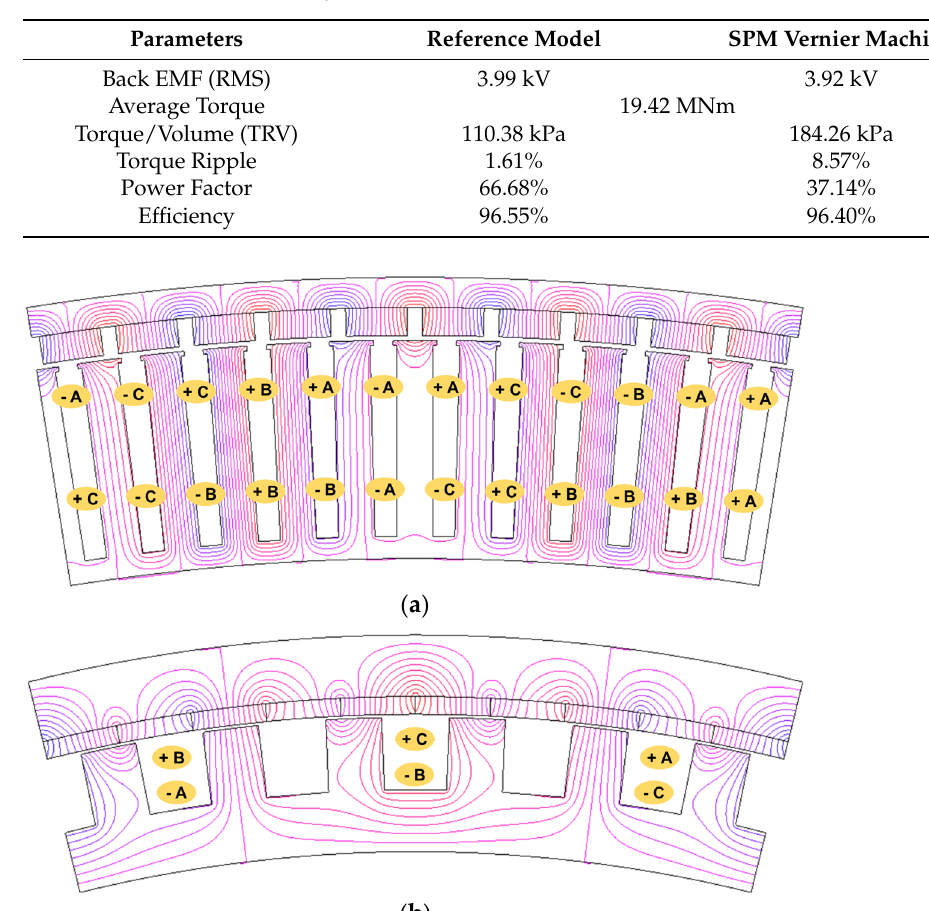
Figure 10. No-load flux lines ( a ) reference model, ( b ) designed SPMVG.